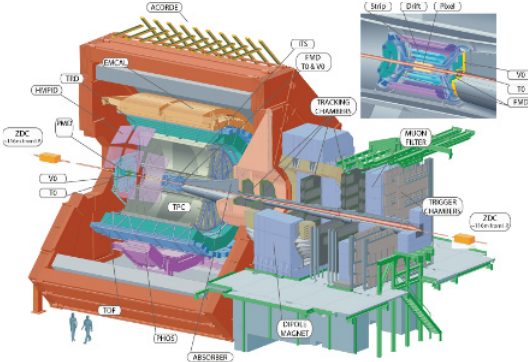
Figure 1. Experimental setup of